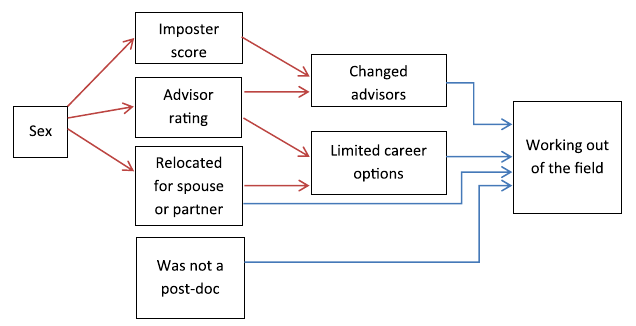
FIG. 1. The indirect effects of sex on whether or not respondent worked out of